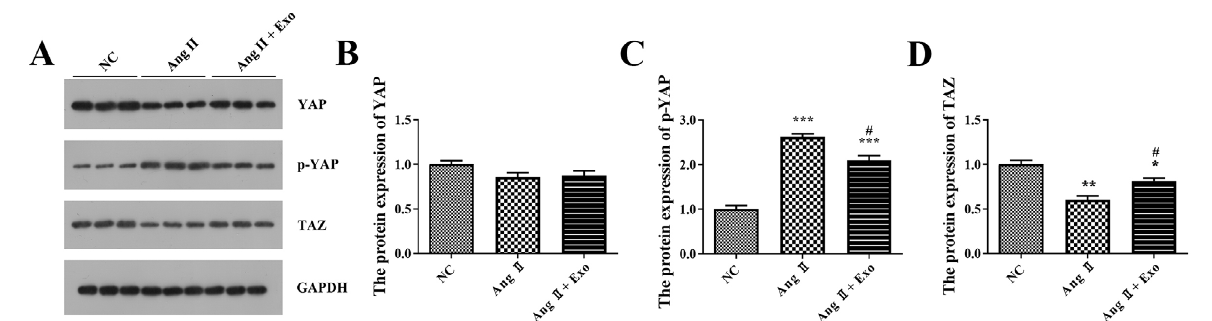
Figure 5 – Hippo-Yes-associated protein (YAP) is involved in the effect of MSCs-exosomes on hypertrophic cardiomyocytes. A-D. Expression levels of YAP, phosphor (p)-YAP, and tafazzin (TAZ) in H9c2 cells were detected by western blotting. H9c2 cells were treated with Ang II or with Ang II + Exo. * P < 0.05, ** P < 0.01, and *** P < 0.001 vs. the NC group; # P < 0.05 vs. the Ang II